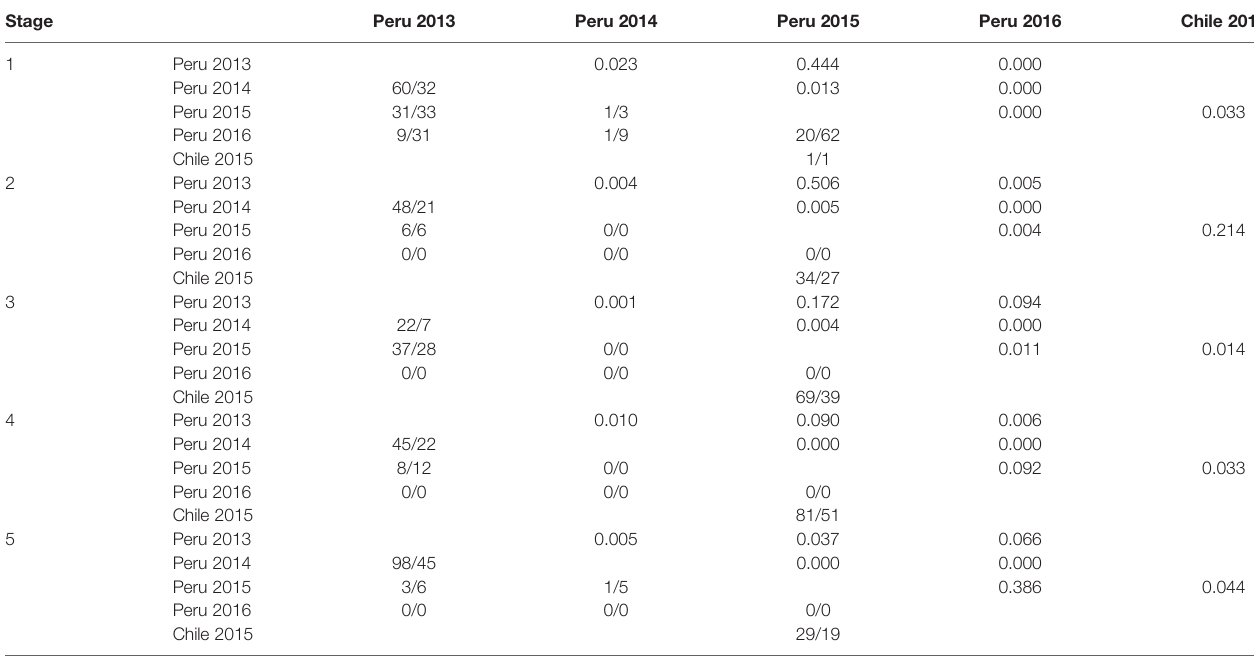
TABLE 6 | Annual and geographic variation in isotopic niche of females during different life stages. Stage